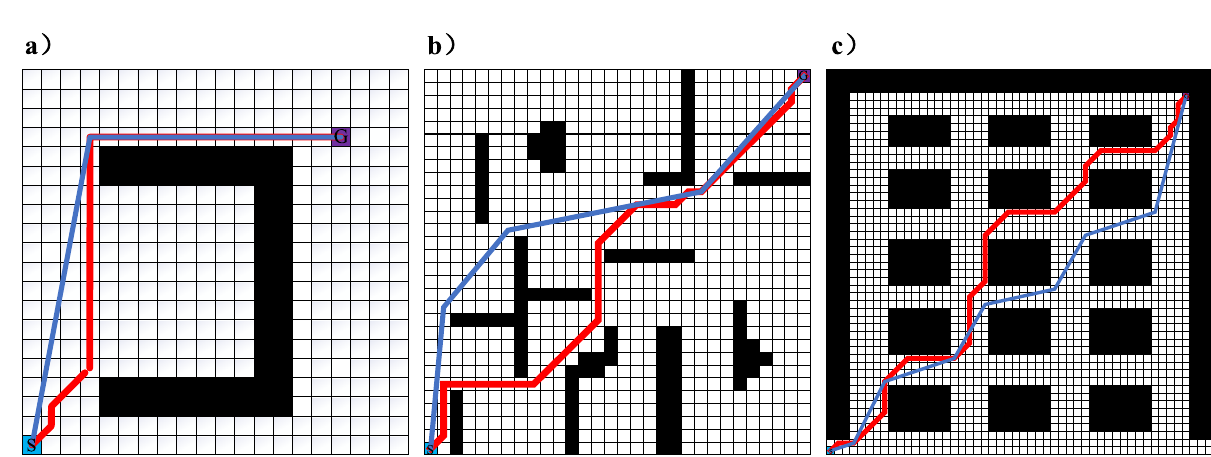
Figure 4. Comparison of the paths generated. ( a ) Map 1 ( b ) Map 2 ( c ) Map